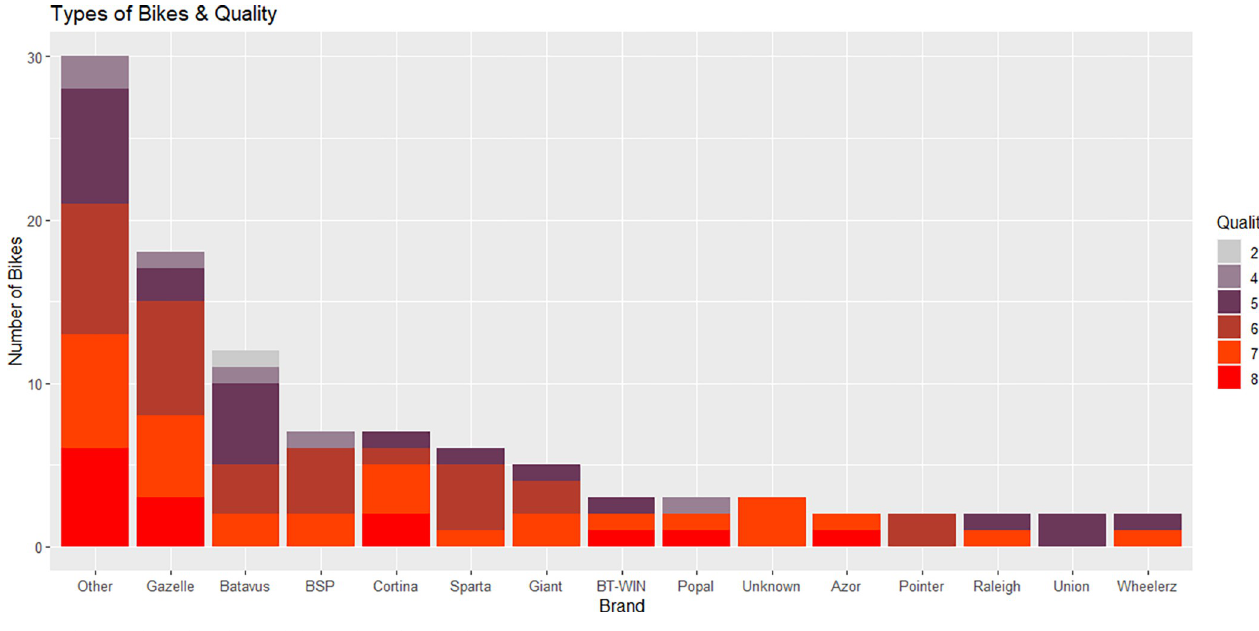
Fig 3. The brands of the bikes and the quality of each bike.